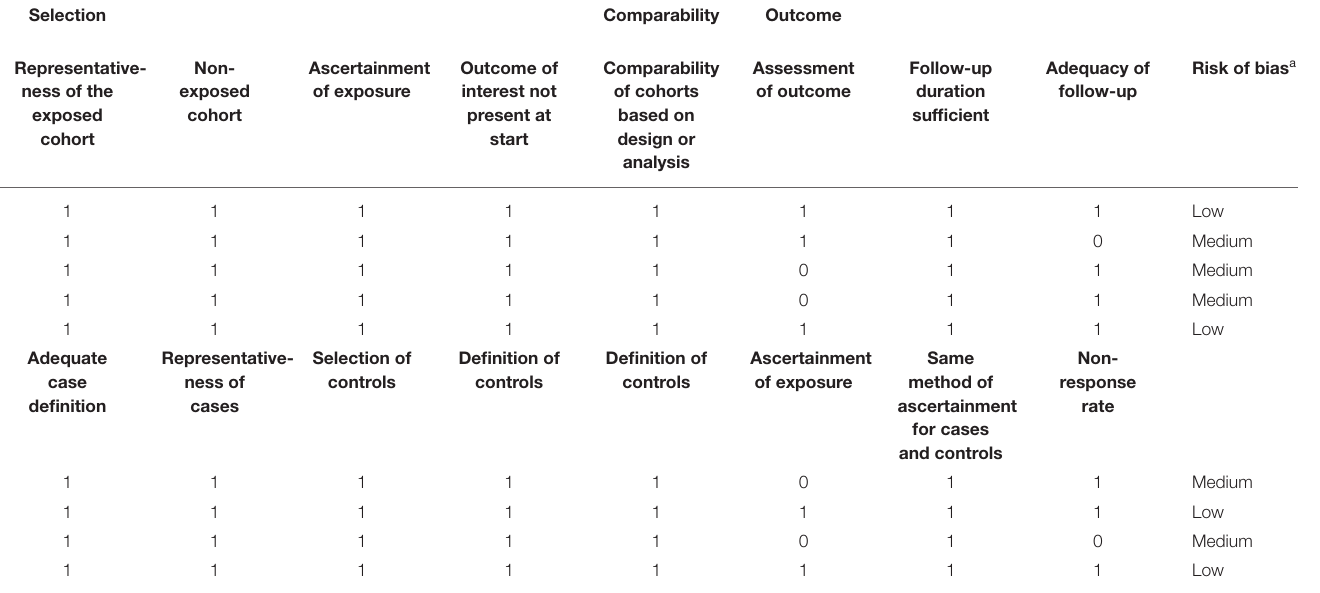
TABLE 2 | Risk of bias in the